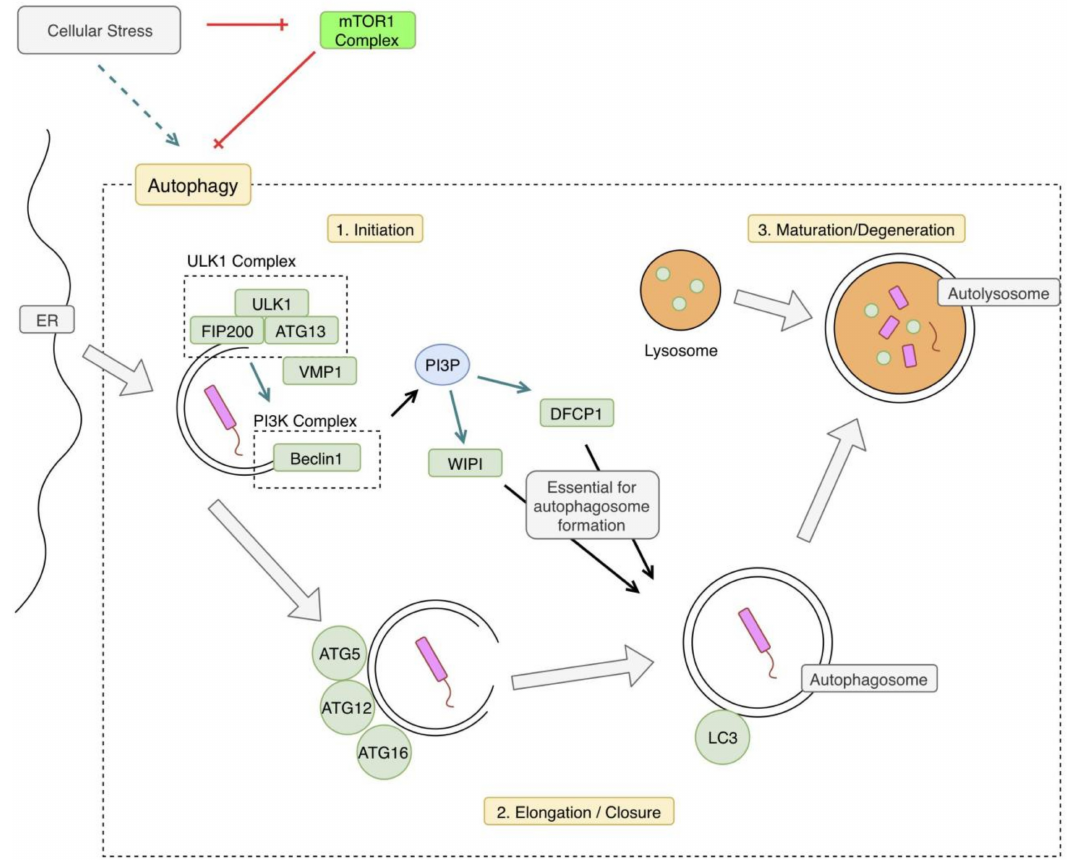
Figure 1. Xenophagy Pathway Overview. Cellular stress including starvation or hypoxia can trigger the autophagy pathway by relieving inhibition by mammalian target of rapamycin 1 (mTOR1). In the case of xenophagy, autophagic mechanisms are triggered by an intracellular pathogen. The pathway begins with phosphorylation of the Unc-51-like Kinase 1 (ULK1) complex, which activates the phosphoinositide 3-kinase complex 3 (PI3KC3) complex. This begins the double-membraned autophagosome formation, which is derived from the endoplasmic reticulum (ER). The next step is elongation and closure of the autophagosome. An autophagy-related protein (ATG) complex comprised of ATG5, ATG12, and ATG16 is involved in this next step. Microtubule-associated protein 1A/1B-light chain 3 (LC3) is also conjugated to the membrane, at this step. Phosphatidylinositol 3 phosphate (PI3P) produced by the PI3KC3 complex is necessary for autophagosome closure, as well. The final step is fusion with a lysosome forming an autolysosome, degrading its contents. VMP1: vacuole membrane protein 1, FIP200: focal adhesion kinase family interacting protein of 200kd, WIPI: WD repeat domain phosphoinositide-interacting protein 1, DFCP1: double FYVE domain-containing protein